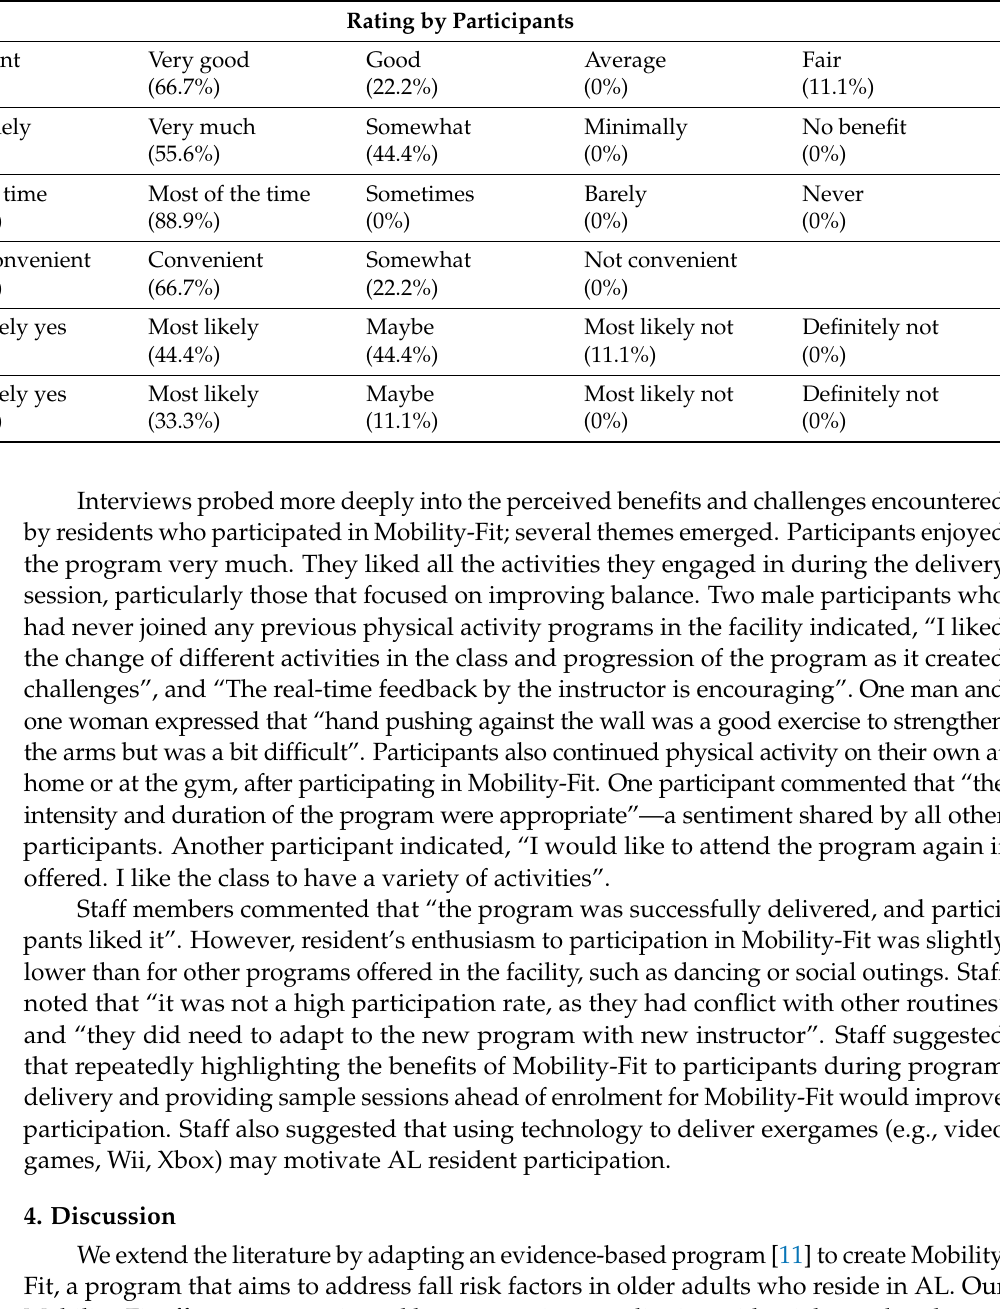
Table 3. Results from the program evaluation form completed by participants in the Mobility-Fit group ( n =